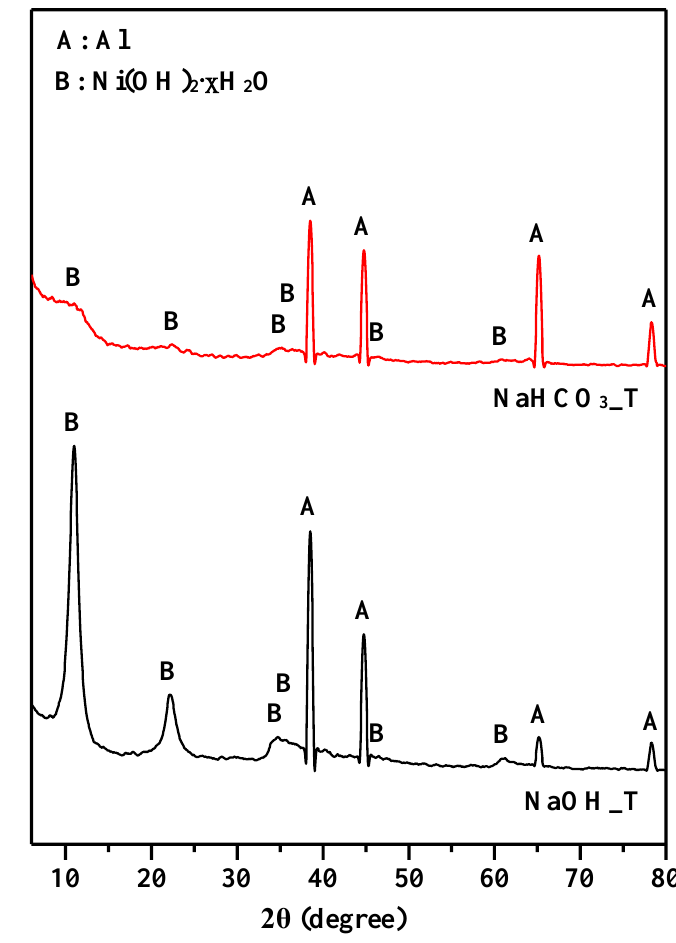
Figure 3. XRD patterns of Ni precursors (fresh catalysts) on the 400 °C calcined LDH@Al substrates for the sample NaOH_T (bottom pattern) and NaHCO 3 _T (top pattern), respectively.